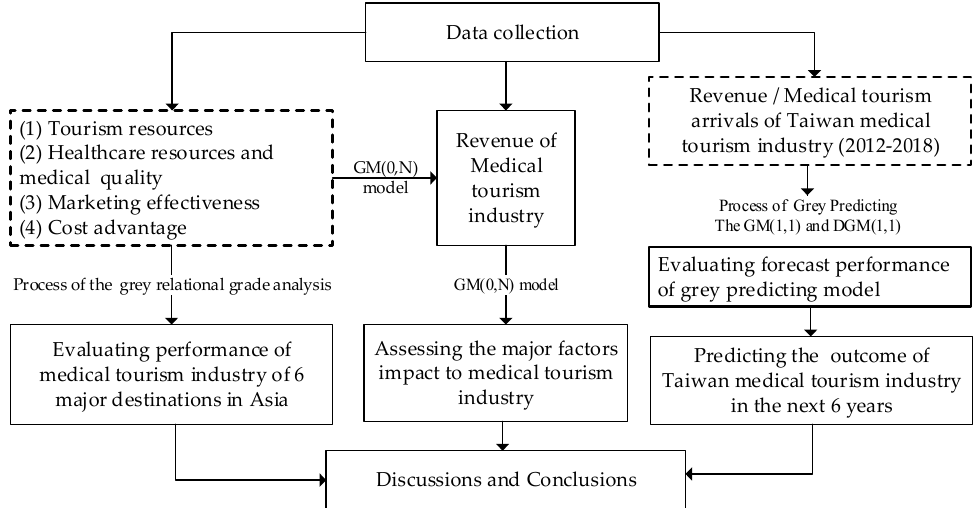
Figure 5. Conceptual framework.